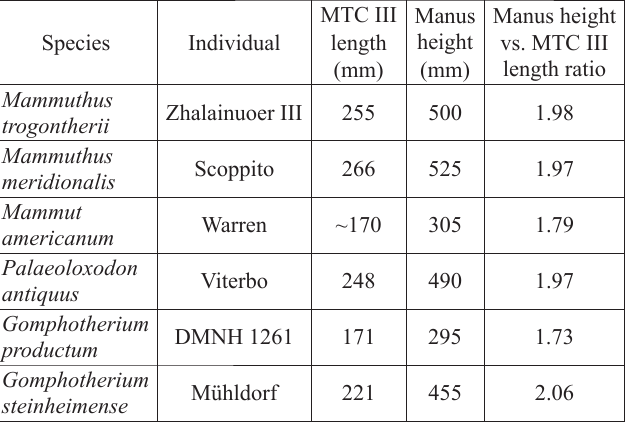
Table 1. Ratios between manus height vs. metacarpal (MTC) III length for different proboscidean species. Skeletal manus heights obtained from the restorations of the Appendix 1.